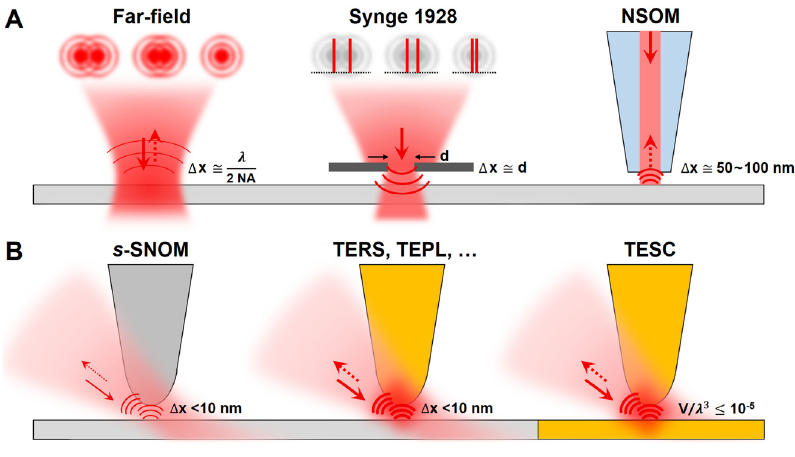
Figure 1: (A) The brief experimental schematics with spatial resolution for far- field optical microscope, Synge ’ s theoretical proposal, and near- fi eld scanning optical microscopy (NSOM). Δ x denotes spatial resolution. (B) Schematics of scattering-type scanning near- fi eld opticalmicroscopy( s -SNOM), tip-enhanced nano-spectroscopy (TERS and TEPL), and tip-enhanced strong coupling (TESC) spectroscopy [37]. V/ λ 3 denotes mode volume for an